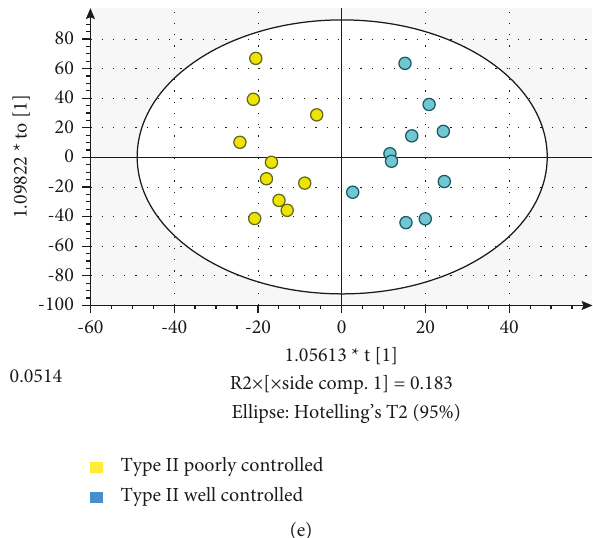
Figure 1: Salivary metabolomics for diabetes. (a) Unsupervised multivariate analysis (PCA) of type I and II diabetes salivary samples with pooled quality control samples tightly clustered and centered; unsupervised PCA analysis did not differentiate poorly and well controlled type I (b) and II (c) diabetes salivary samples; (d) supervised analysis (OPLS-DA) of type I diabetes (d) and type II (e) saliva samples differentiated these poorly and well controlled subjects saliva samples.